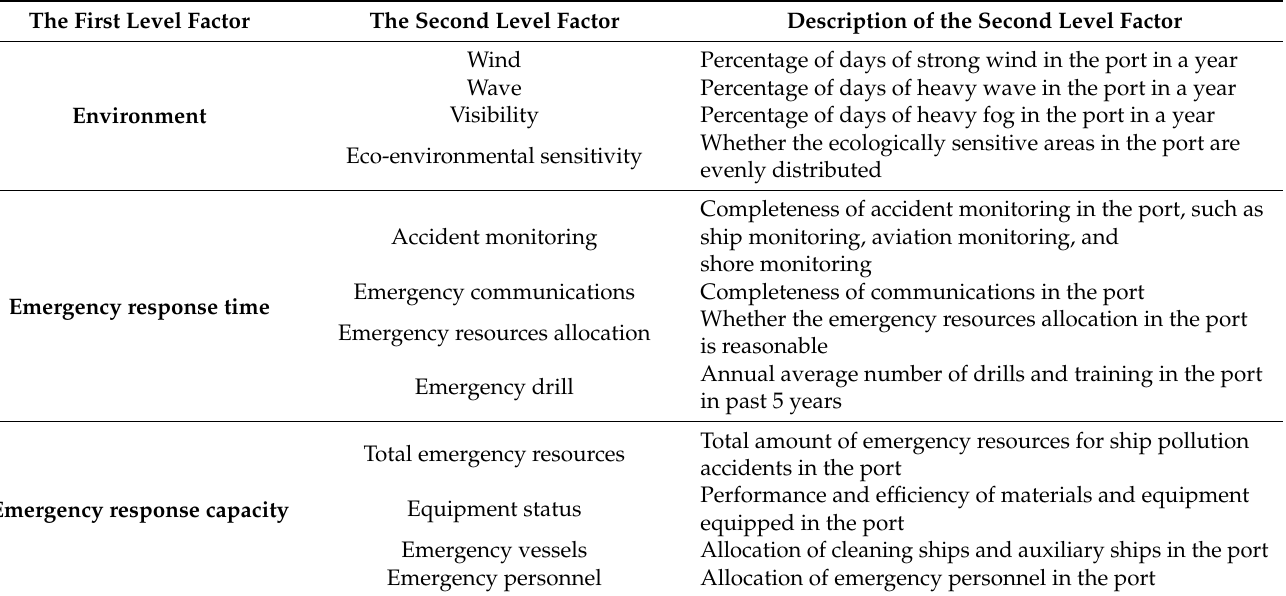
Table 1. Bayesian network node for ship pollution emergency